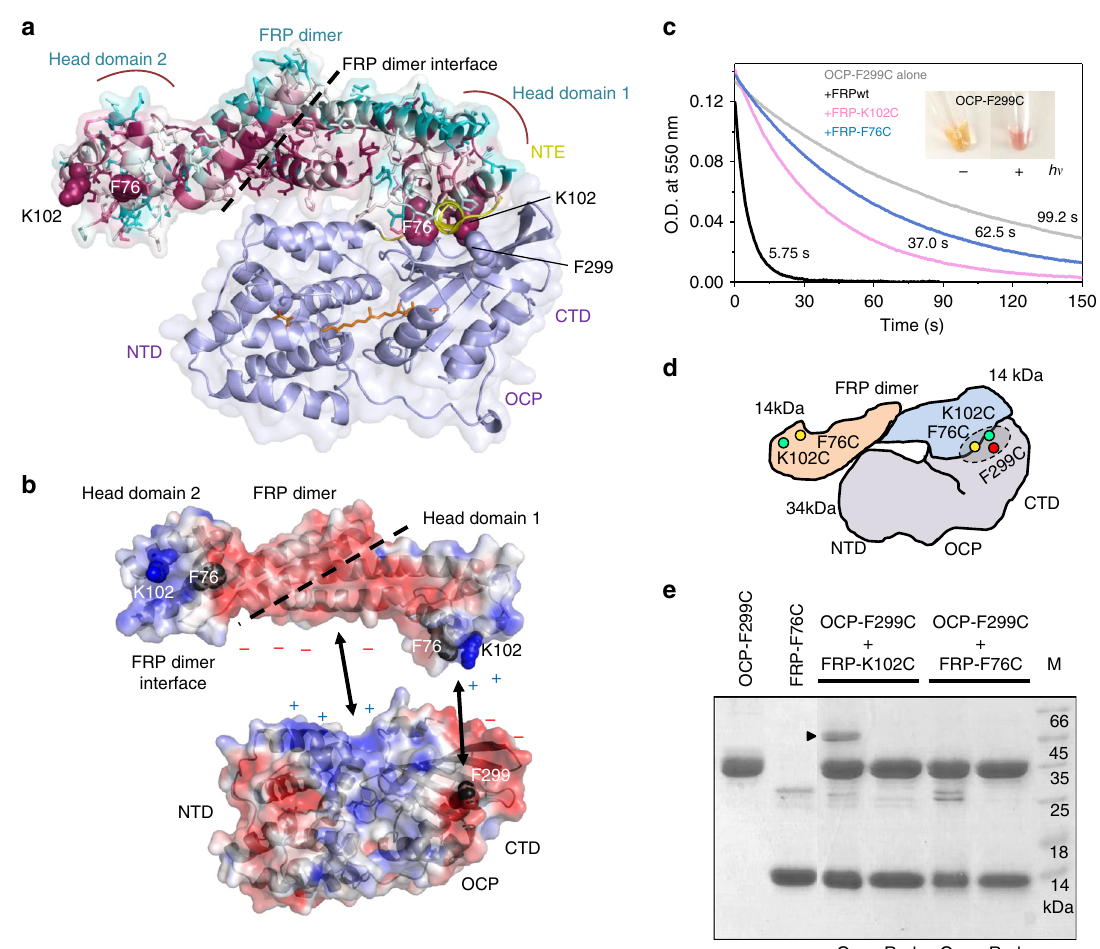
Fig. 6 Validation of the proposed topology of the OCP – FRP complexes. a The SAXS-derived structural model of the 1:2 Δ NTE O – FRP complex with FRP residues colored by a gradient from conserved (purple) to variable (cyan) using Consurf 65 . OCP is shown in light-violet with the carotenoid in orange. Note high conservation on the concave side of the FRP dimer and that (i) binding of the fi rst head domain of FRP occurs on the OCP – CTD in place of the NTE (shown in yellow), (ii) presumable contact area includes F299 of OCP and K102 and F76 of FRP, whereas (iii) the second head domain of FRP is open for the interaction with another OCP molecule and (iv) the dimer interface of FRP is not directly involved in OCP binding. b Distribution of the regions with positive ( + 3 k T e − 1 ; blue) and negative ( − 3 k T e − 1 ; red) electrostatic potentials on surface of FRP and OCP suggesting extended multisite binding, in agreement with the scaffolding role of FRP. c Functional interaction of Cys mutants of OCP and FRP assessed by the ability of FRP variants to accelerate the R – O conversion of the photoactivated OCP – F299C at 25 °C. Insert shows the color of the OCP – F299C sample in the dark and under actinic light. d Schematic picture of the 1:2 complex with the positions chosen for Cys mutagenesis and disul fi de trapping. The dashed circle indicates the tentative OCP – FRP interface. e The ability of Cys mutants to form disul fi de crosslinked heterocomplexes upon mild oxidation by GSH/GSSG of the OCP – F299C mixtures with either FRP – K102C or FRP – F76C mutants. M w markers (M) are indicated in kDa. Ox and Red designate the absence or presence of β ME in the sample buffer. Arrowhead marks the 46 kDa band corresponding to the OCP – FRP complex fi xed by disul fi de bond and disappearing upon